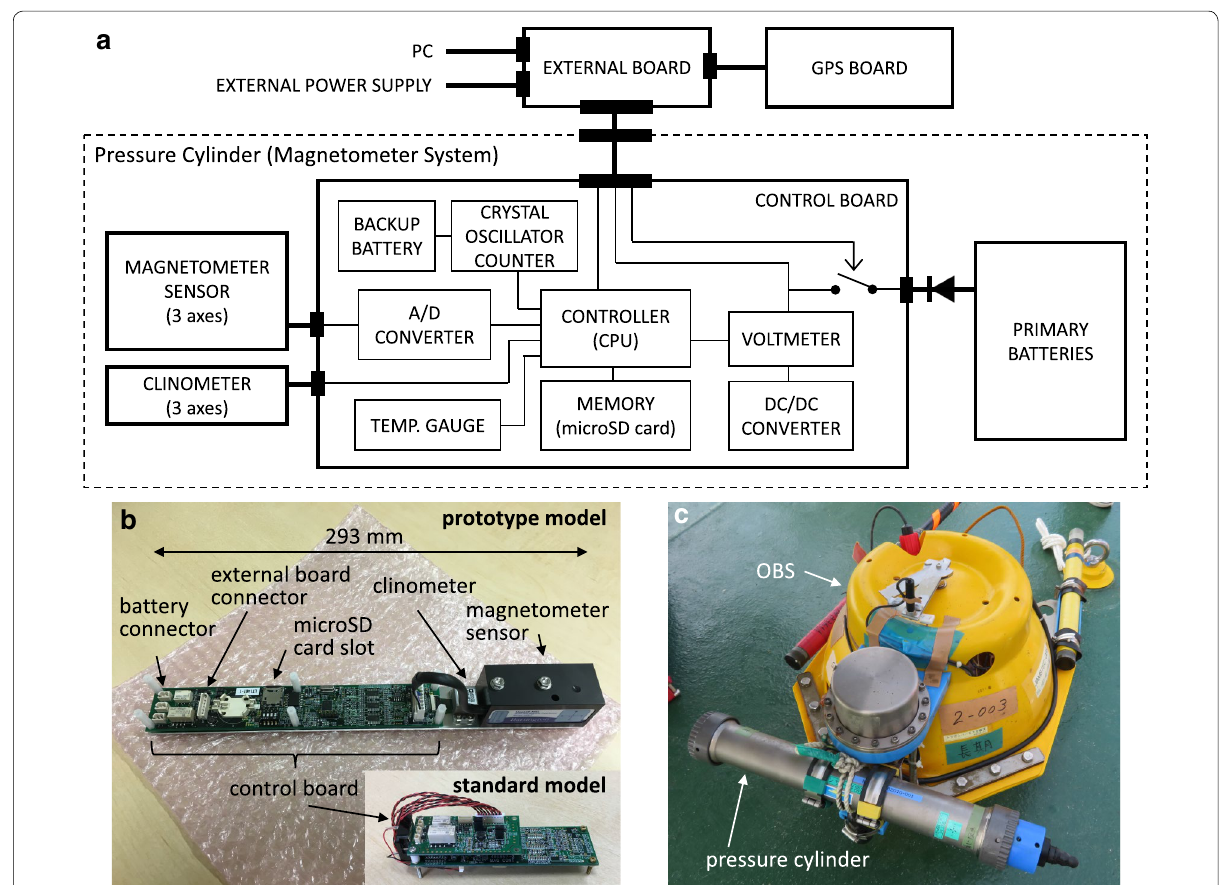
Fig. 1 a A functional block diagram of the magnetometer system. The dashed box indicates the magnetometer system that is installed in the pressure cylinder, and the black-filled boxes indicate connectors, respectively. b Photograph of the magnetometer system setup with the prototype model of the control board (without primary batteries) and the control board of the standard model. c Photograph of a setup appearance of the magnetometer system within the pressure cylinder. It was attached to an ocean-bottom seismometer (OBS) for the first in situ observation test on the